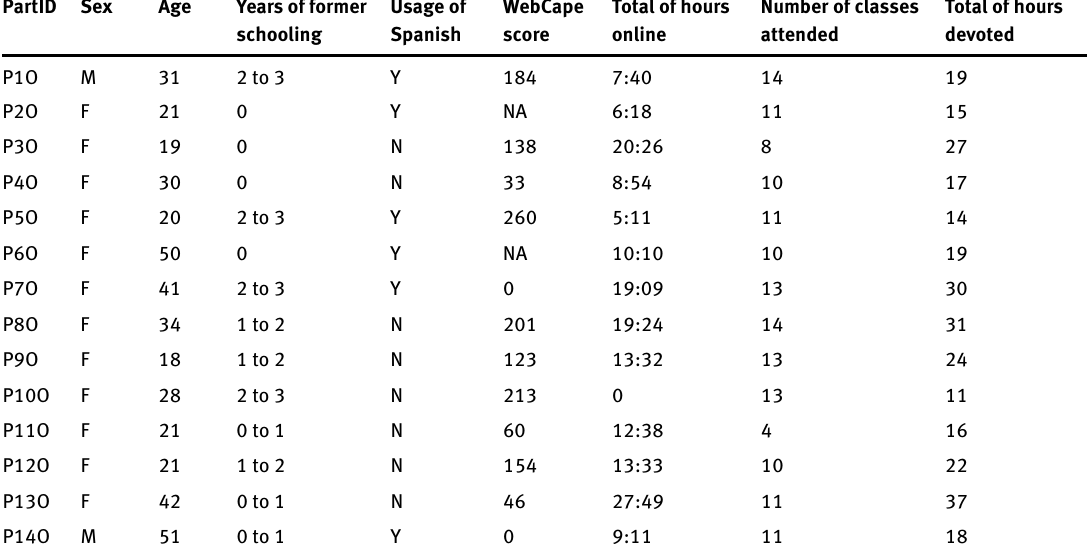
Table 1. Online students of Beginning Spanish 1.